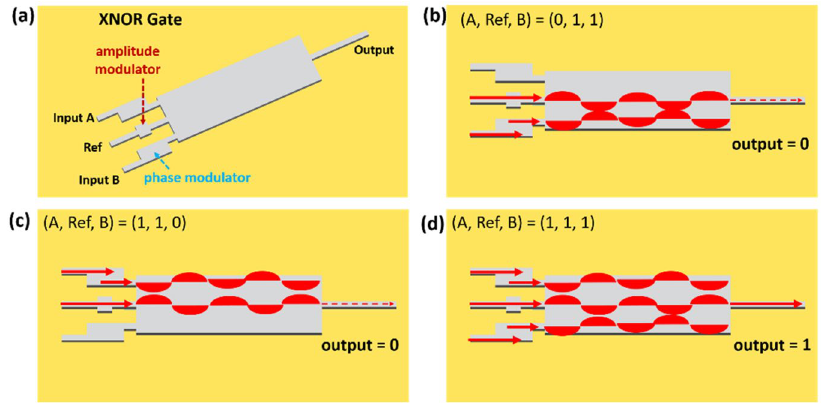
Figure 1. ( a ) The schematic diagram of plasmonic XNOR gate. Input A and input B contain a phase modulator. The Ref channel has an amplitude modulator. ( b , c ) The cases of zero output when (A, Ref, B) = (0, 1, 1) and (1, 1, 0). ( d ) The case of unitary output when (A, Ref, B) = (1, 1,